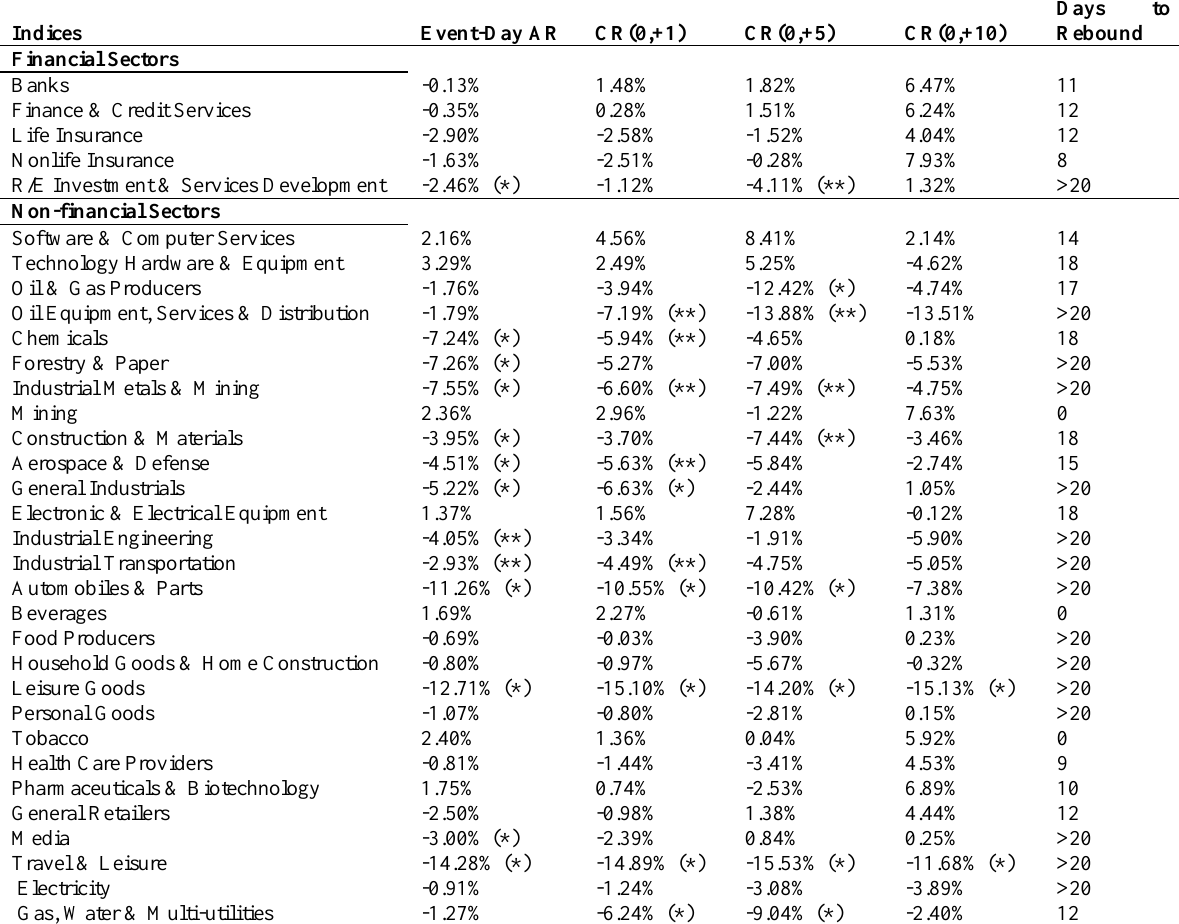
Table 1: Event study analysis: response of sector indices to 11-Sep. terrorist incidents